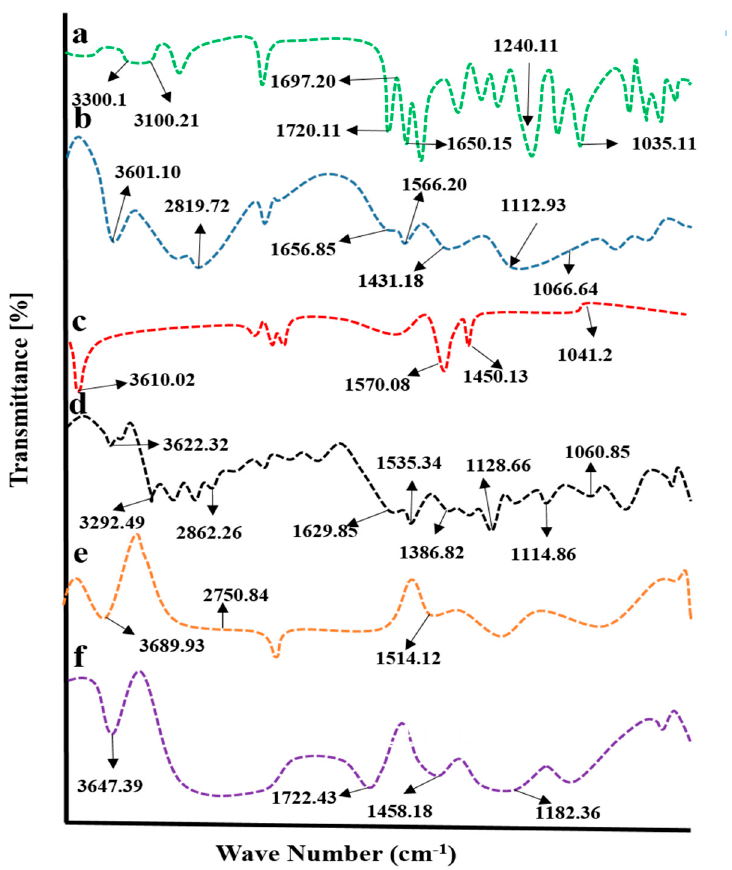
Figure 4. FTIR spectra of ( a ) capecitabine, ( b ) chitosan, ( c ) fenugreek extract, ( d ) physical mixture, ( e ) blank hydrogel, and ( f ) drug ‐ loaded hydrogel.